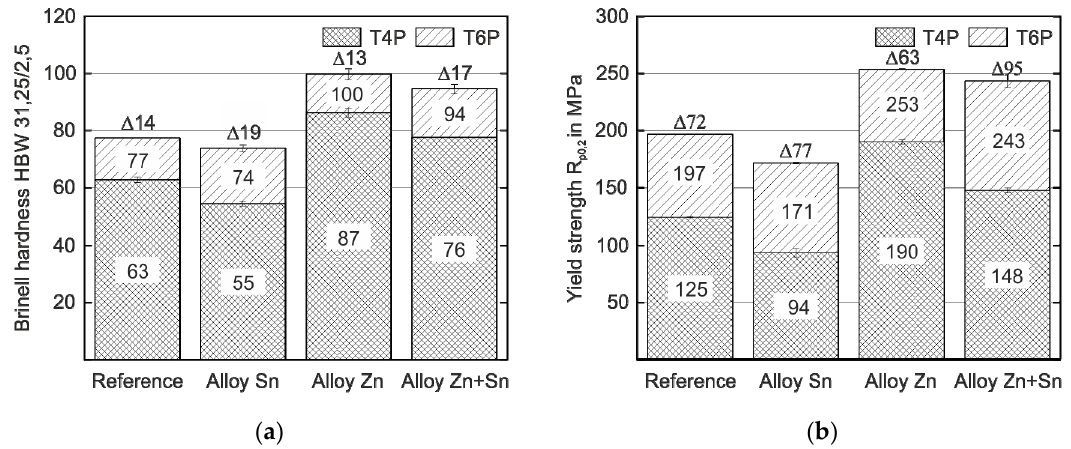
Figure 1. Hardness ( a ) and yield strength values ( b ) of the reference and experimental alloys in the T4P and T6P conditions (average scatter ± 1 HBW and ± 2 MPa, respectively). The hardness and strength difference, ∆ , between T4P and T6P states is indicated.